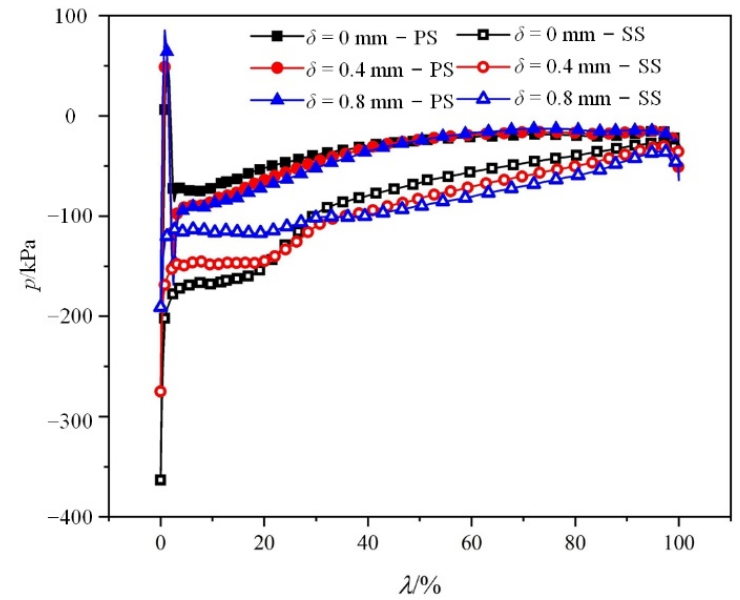
Figure 13. Variation in pressure on the impeller blade surface of the 0.5 span.